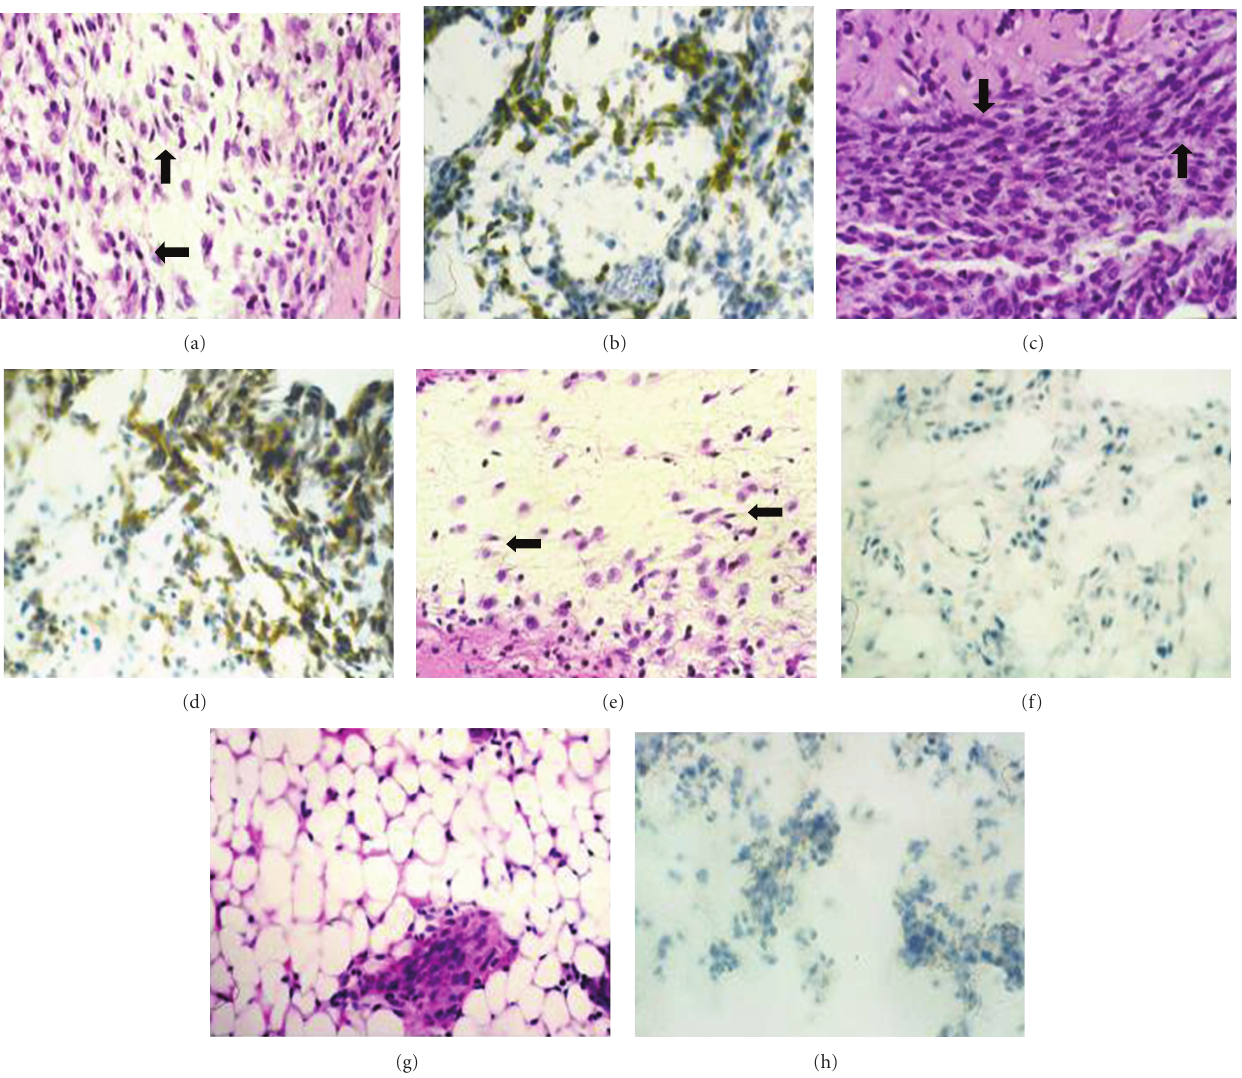
Figure 1: Induction of Bcl-2 expression in mice by FGF-2 and Tat. Mice were injected with 1 μ g of FGF-2 and/or 10 μ g of Tat, as described in Section 2. After 7 days tissue samples were taken at the injection sites and processed for histological examination by hematoxylin-eosin staining (left panels, 40X magnification). Tissue sections from 12 animals per group were stained with anti-Bcl-2 antibody (right panels, 40X magnification). Induction of KS-like lesions promoted by 1 μ g FGF-2 (a) was associated with Bcl-2 protein expression (b). The simultaneous inoculation of 1 μ g FGF-2 and 10 μ g Tat further increased both lesion development (c) and Bcl-2 expression (d). The inoculation of 10 μ g Tat alone induced only limited histological alterations (e) and no Bcl-2 protein expression (f) at the injection sites. Protein suspension bu ff er (PBS-0.1% BSA) did not promote lesion development (g), nor Bcl-2 protein expression (h). Arrows point at some representative spindle cells of KS-like